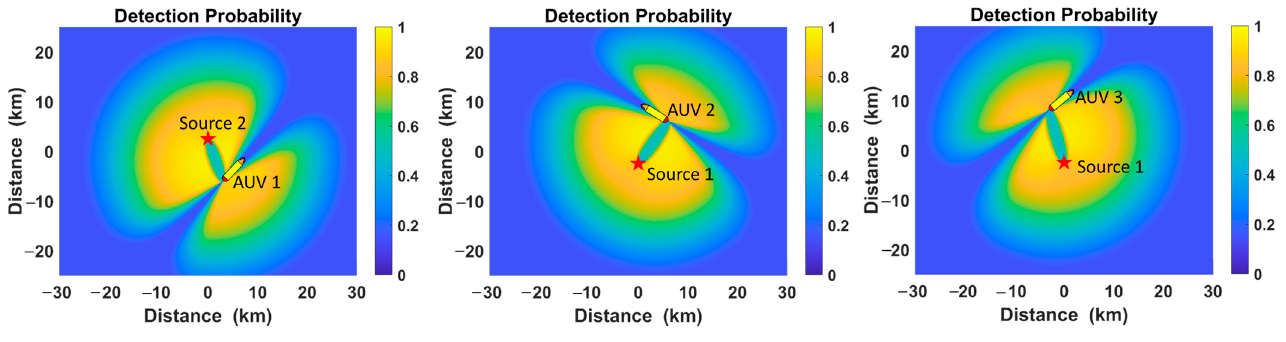
Figure 6. Target detection probabilities of di ff erent S/R pairs at time step t = 1.